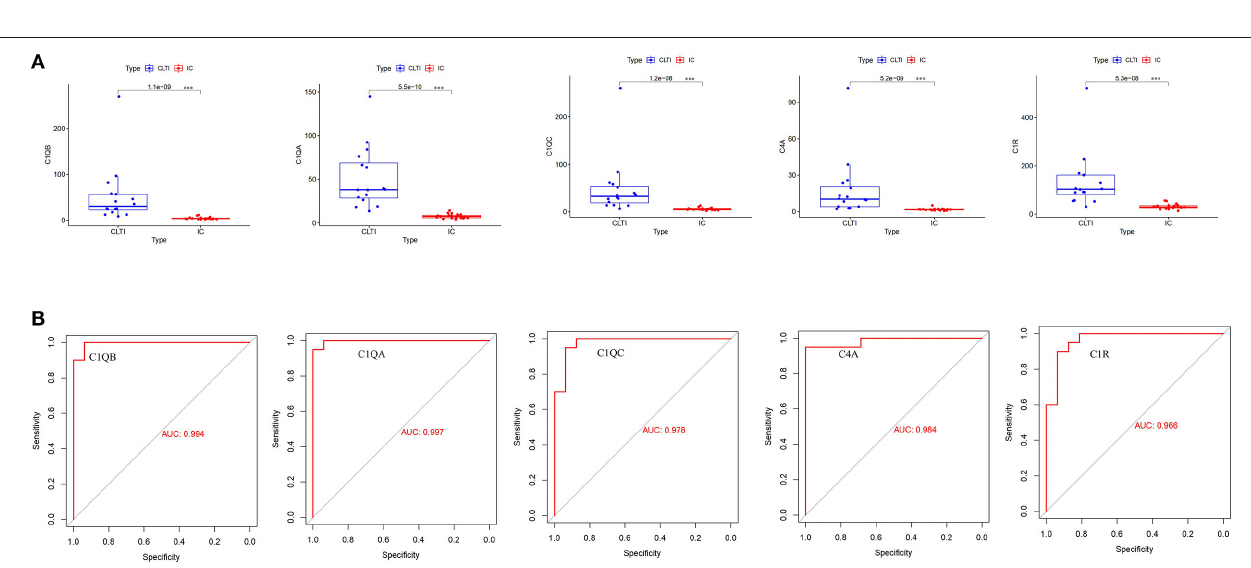
FIGURE 5 | The identification of the hub genes. (A) Hub genes were identified from the PPI network using the MCC algorithm. Edges represent the protein–protein associations. The red nodes represent genes with high MCC scores, while the yellow nodes represent genes with low MCC scores. (B) The top 10 genes with a high MCC score are listed, and the top 5 were identified as hub genes. PPI, protein–protein interaction; MCC, maximal clique centrality.